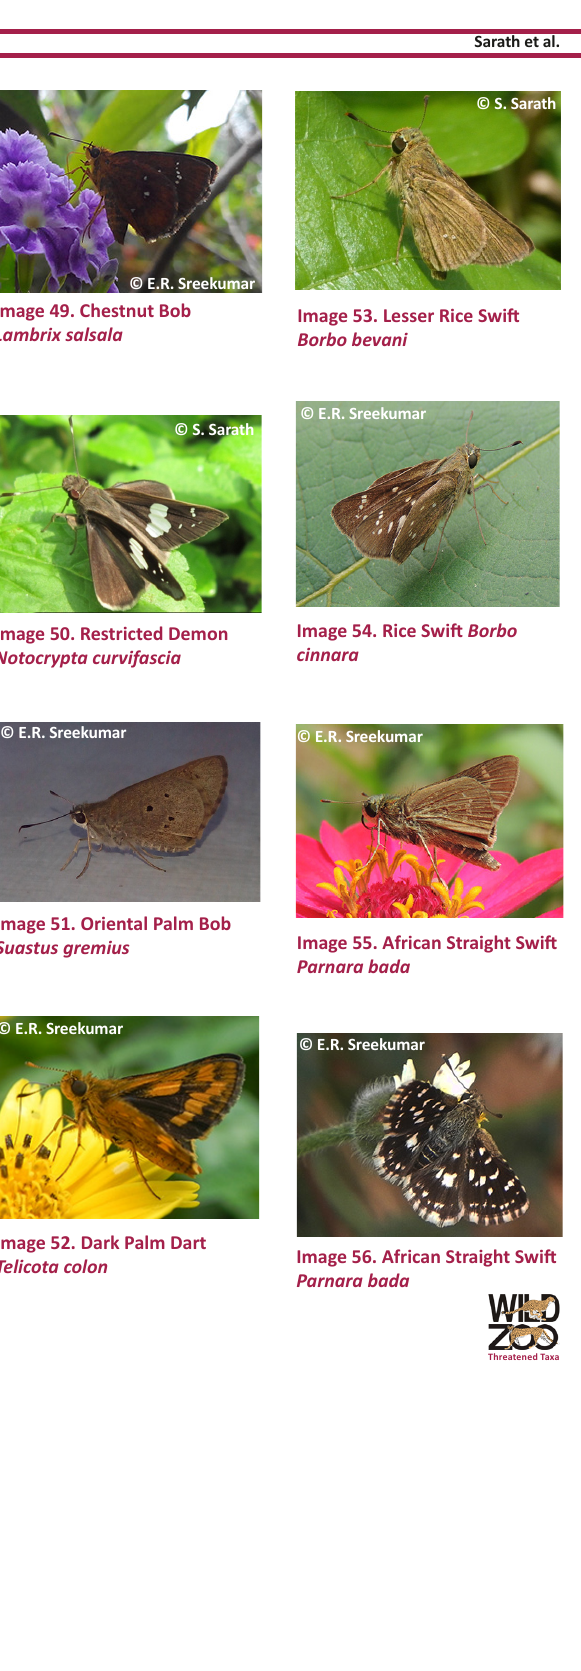
Image 49. Chestnut Bob Lambrix salsala